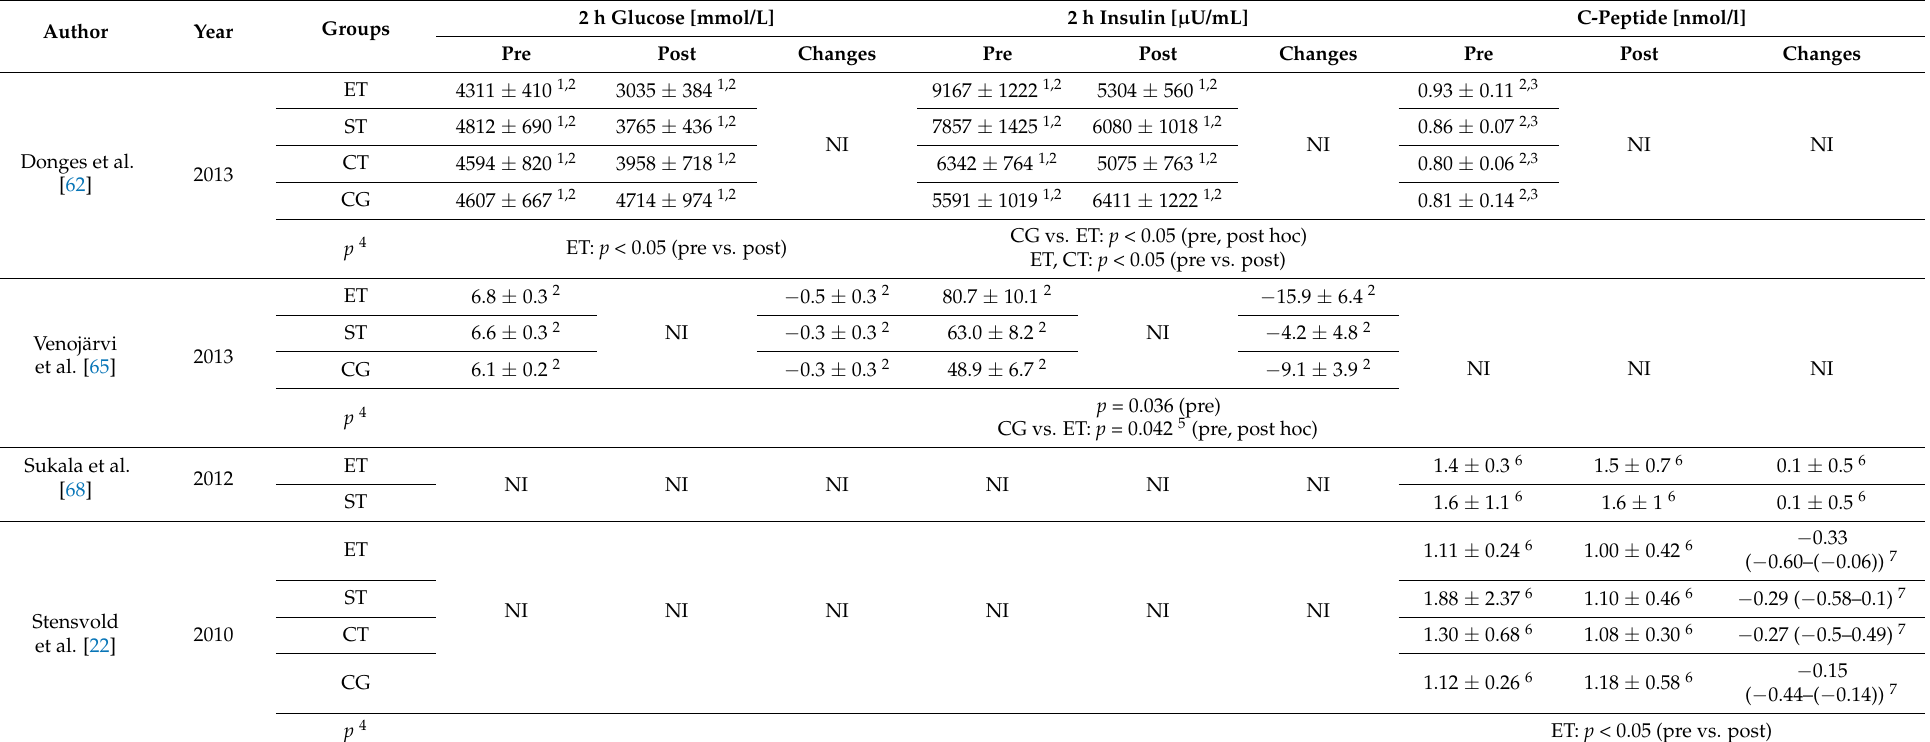
Table 4. Glucose and insulin metabolism parameters in studied